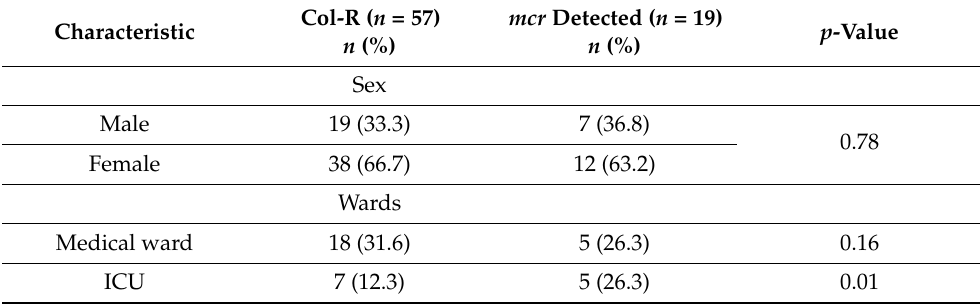
Figure 1. Flow diagram showing the collection of clinical specimens, the isolation of bacterial strains, and the inclusion and exclusion of bacterial strains in the study. ESBL, extended-spectrum β -lactamase; MIC, minimum inhibitory concentration. Table 1. Characteristics of cases infected with colistin-resistant (Col-R) and mcr -positive gram- negative bacterial strains.